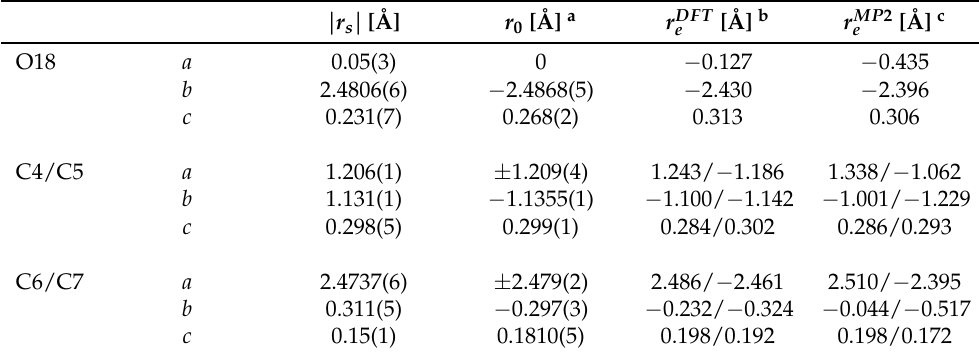
Table 3. Substitution ( r s , C s ), ground state ( r 0 , C s ) and equilibrium ( r e , C 1 ) principal axis system coordinates of DEHA-W.